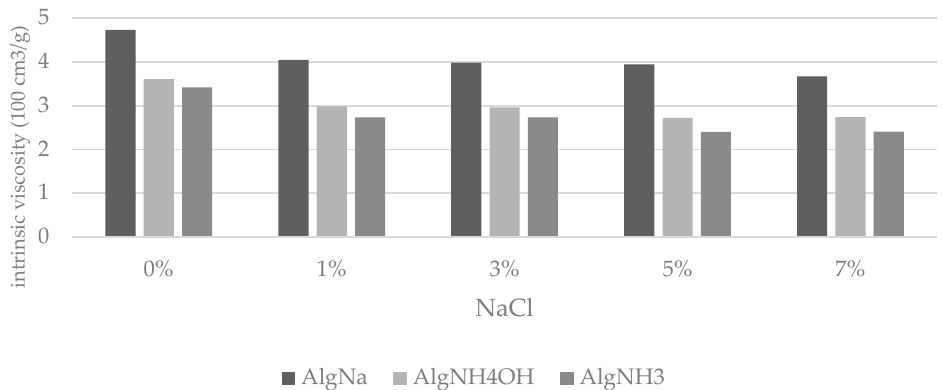
Figure 4. The comparison of intrinsic viscosity values of solutions depending on NaCl concentration after 48 h.